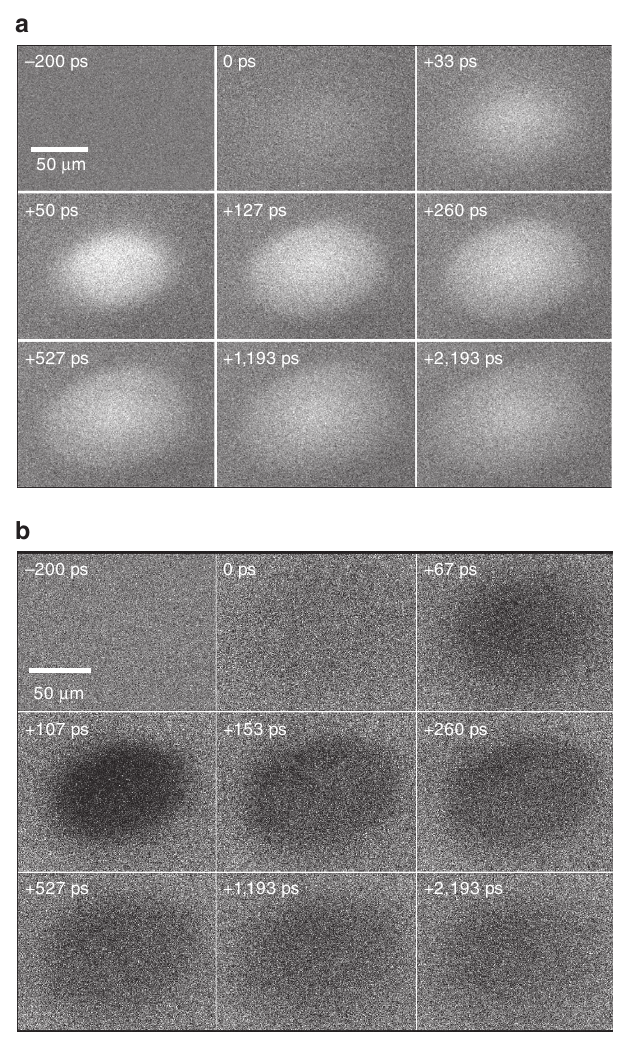
emission signal (Fig. 1). The band bending and local potential at